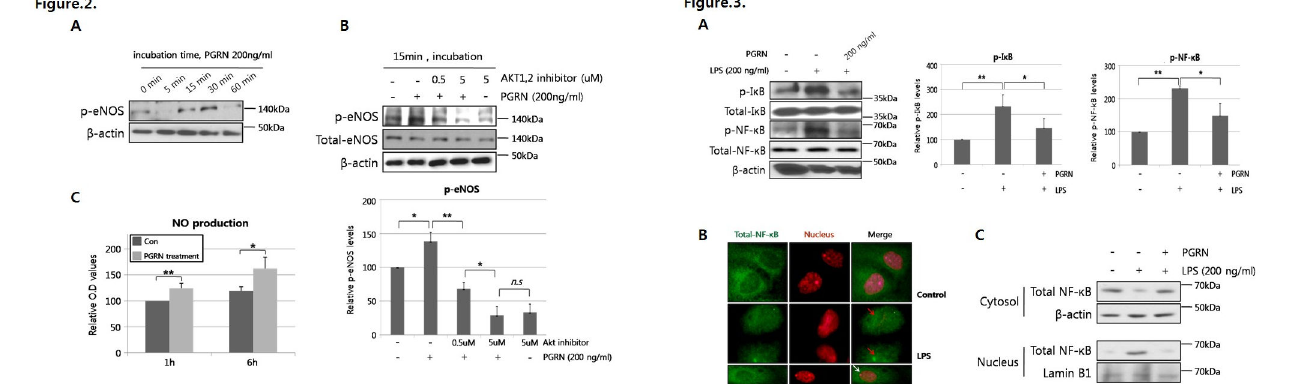
Figure 2. Progranulin (PGRN) induced activation of the Akt/eNOS/NO pathway in HUVECs. (A) Cells were incubated with 200 ng/mL of progranulin for 0, 5, 15, 30, or 60 min and analyzed by Western blotting for phosphorylated-eNOS (p- eNOS) level. (B) HUVECs were stimulated with 200 ng/mL of progranulin with or without Akt inhibitor (0.5 or 5 µM) for 15 min, and p-eNOS level was measured by Western blotting. (C) Cells were incubated with 200 ng/mL of progranulin for the indicated times. NO production was analyzed from culture media using the Griess reagent, and OD values were measured at 540nm. Data were obtained from three separate experiments. Error bars represent mean ±SD (n.s.: not significant; *, P < 0.05, **, P < 0.005, t -test)..